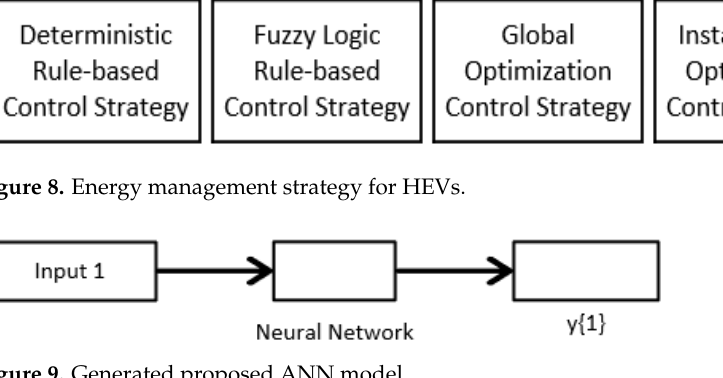
Figure 9. Generated proposed ANN model.